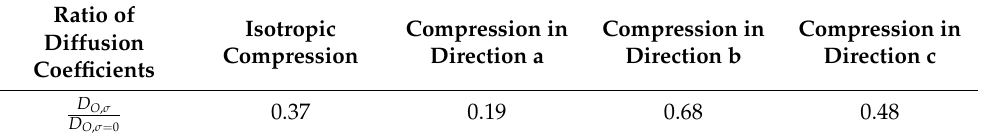
Table 4. Ratio of diffusion coefficients of oxygen vacancies in the presence and absence of 1 GPa compressive stresses with different